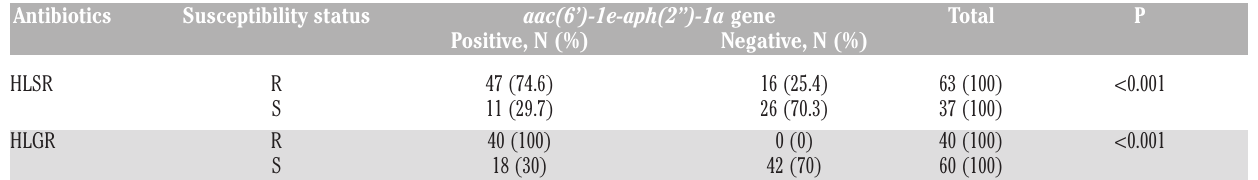
Table 6. High-level gentamicin resistance (HLGR) and high-level streptomycin resistance (HLSR) rates of strains containing a ac(6’)- 1e-aph(2’’)-1a gene. Antibiotics Susceptibility status